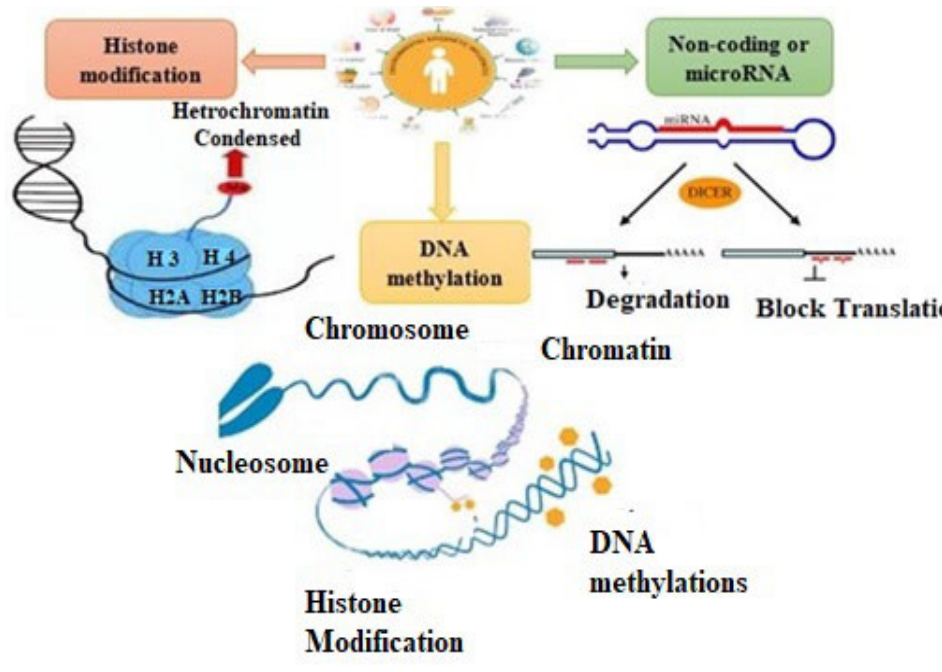
Figure 1. Epigenetics and environmental factors.